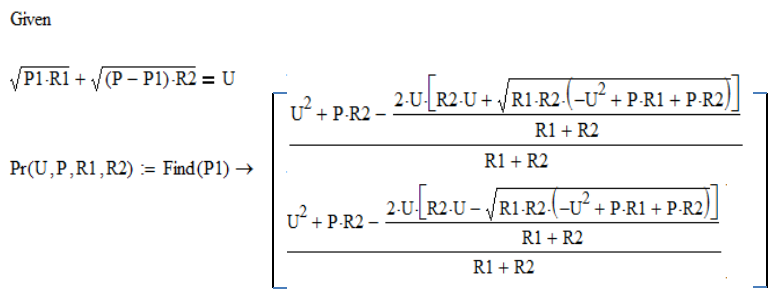
Figure 5. Listing of the Mathcad program for the symbolic solution of Equation (8).